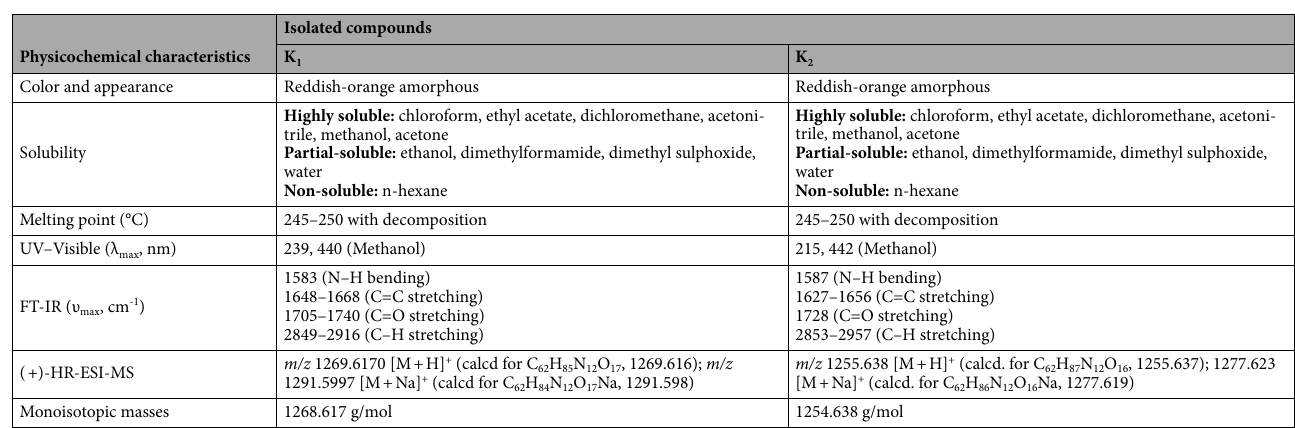
Table 1. Physicochemical characteristics of the isolated compounds K 1 and K 2